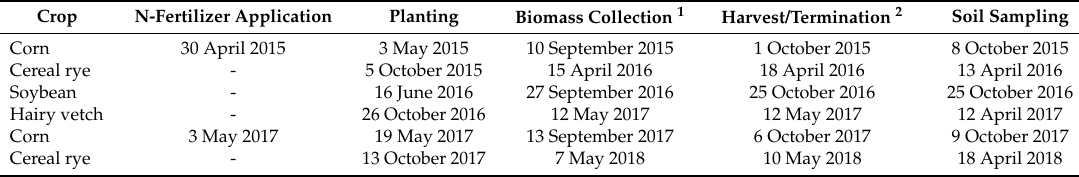
Table 1. Dates of field operations and data